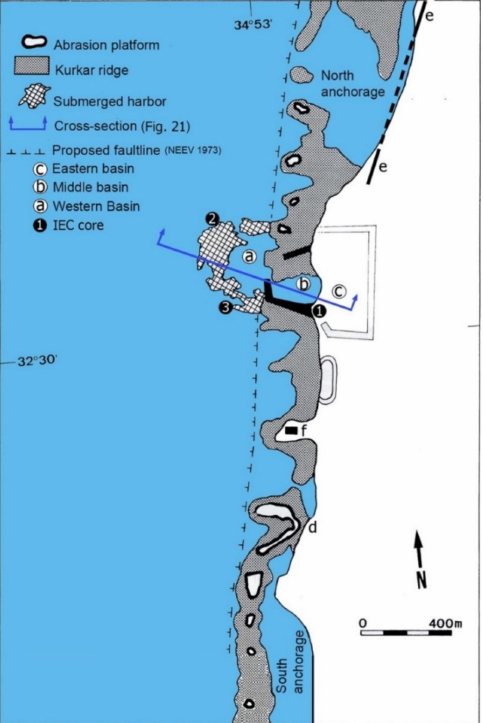
Figure 5. The Caesarea region: the western, central and eastern harbor basins (a, b and c, respectively, Table 1